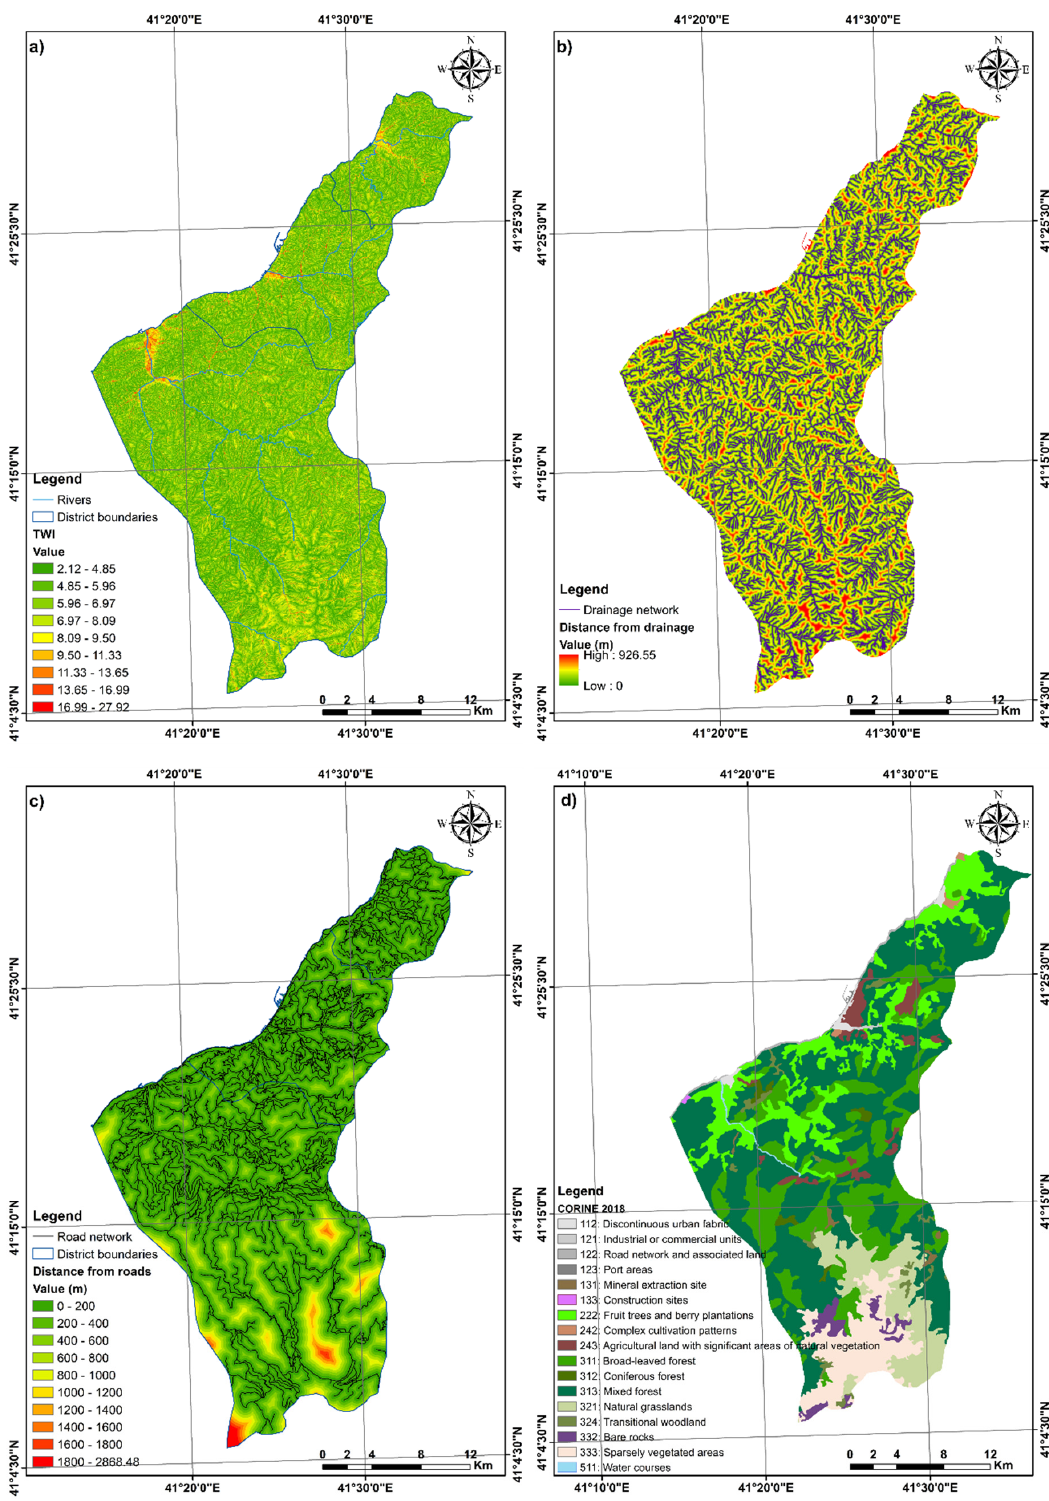
Figure 3. Landslide-conditioning factor maps: ( a ) topographic wetness index (TWI); ( b ) distance from drainage; ( c ) distance from roads; ( d ) land cover.